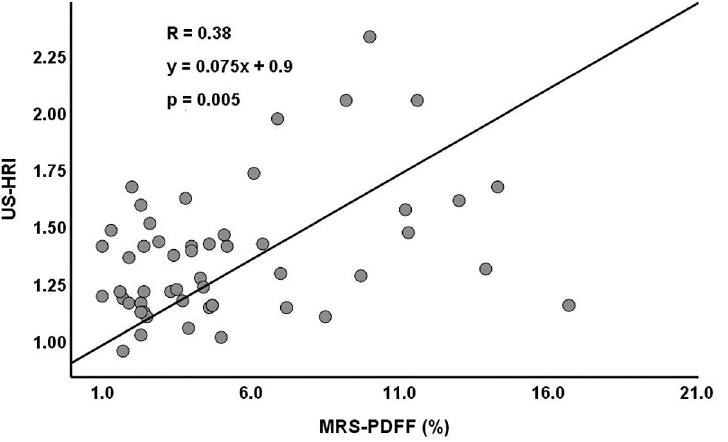
Fig 4. Correlation between US-HRI and